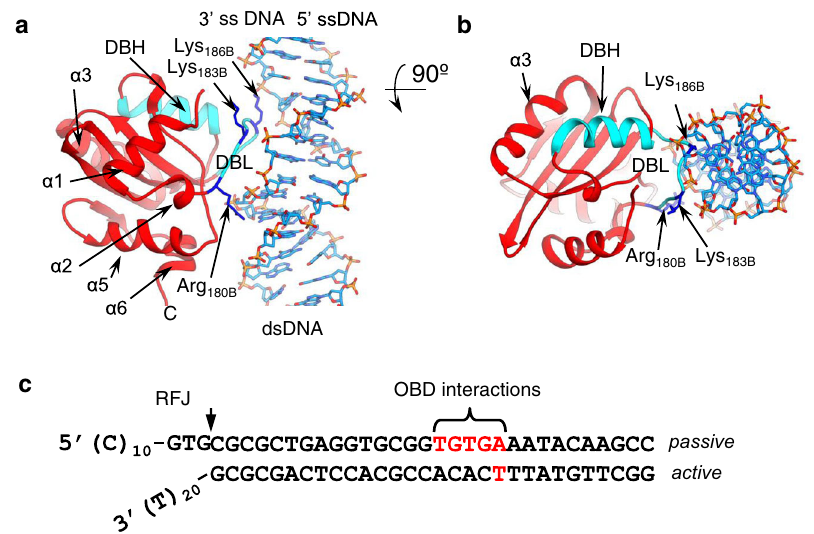
Fig. 3 Interaction of OBD B with dsDNA. a The fi tted atomic model for OBD-B (in red, α -helices labelled) with the DBH (Thr239-Asn248) and the DBL (Arg180-Asn189) shown in cyan. The DBL interacts with the dsDNA. b The interaction of OBD B is viewed from the top showing Lys183 and Lys186 interacting with the dsDNA. c The interaction of OBD B with dsDNA projected on the fork sequence, interacting sequence highlighted in red.